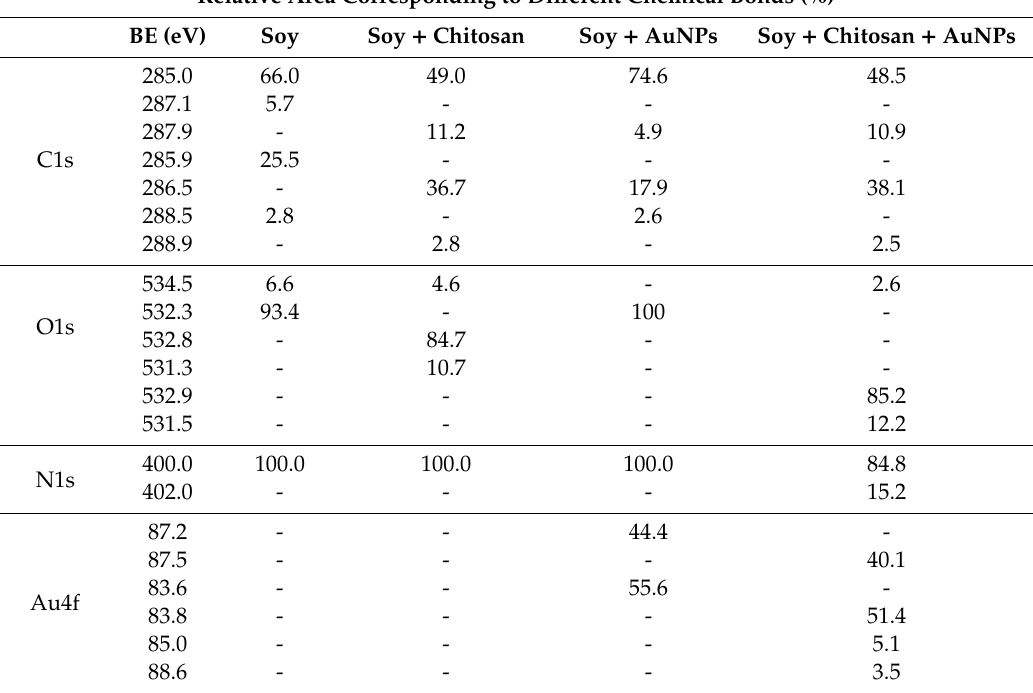
Table 2. Results of the deconvolution analysis of the C1s, N1s, O1s and Au4f peaks of soy fabrics coated with chitosan and AuNPs. Reported binding energies have an associated error of ± 0.1